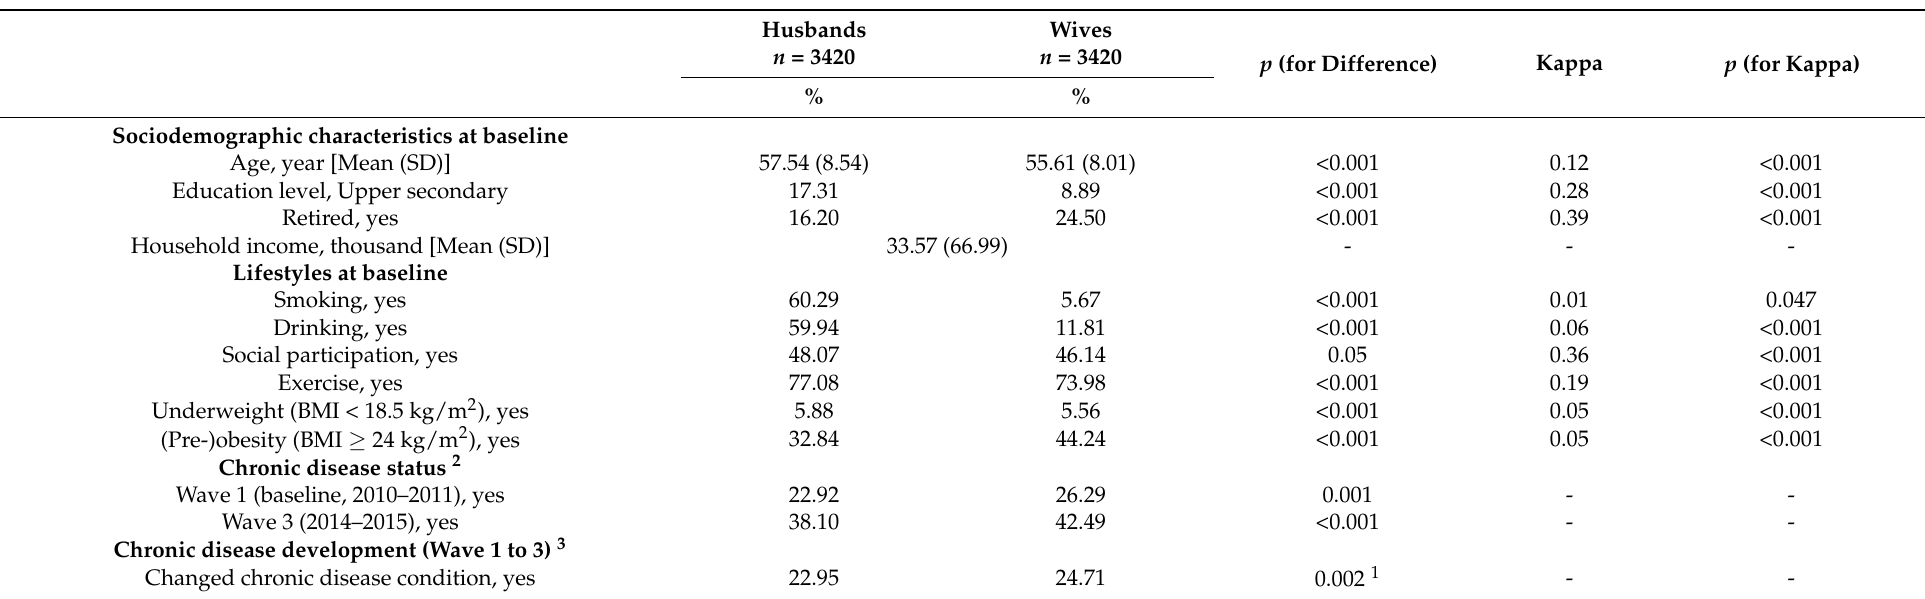
Table 1. Baseline characteristics and chronic disease status at Wave 1 and Wave 3 by gender (3420 couples).